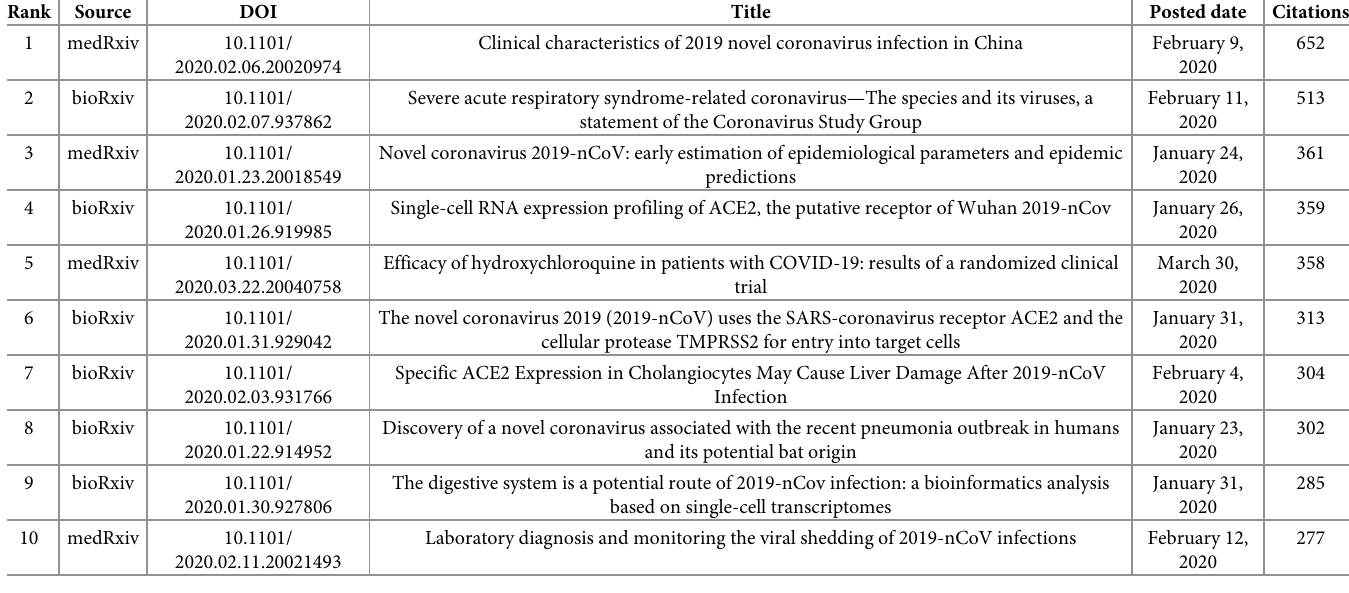
Table 1. Top 10 cited COVID-19